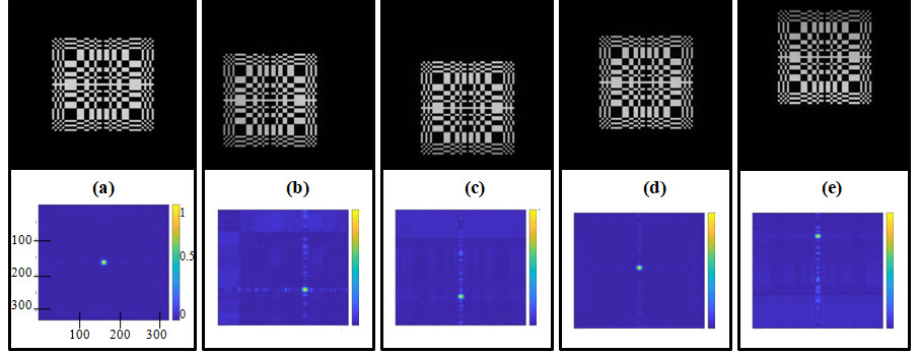
Figure 4. Five Geant4 simulated (up) and decoded (down) images: ( a ) PSF, ( b ) location 8, ( c ) location 17, ( d ) location 19 and ( e ) location 21. The same scale and legend remains valid for other subplots, as given in ( a